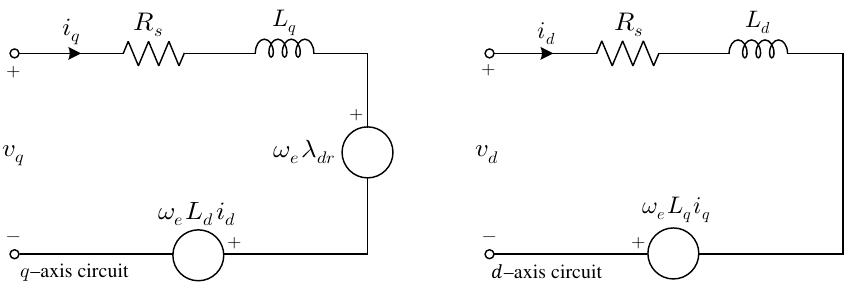
Figure 3. Equivalent electrical circuit diagram of the permanent magnet synchronous machine (PMSM) in dq -axes synchronous reference frame